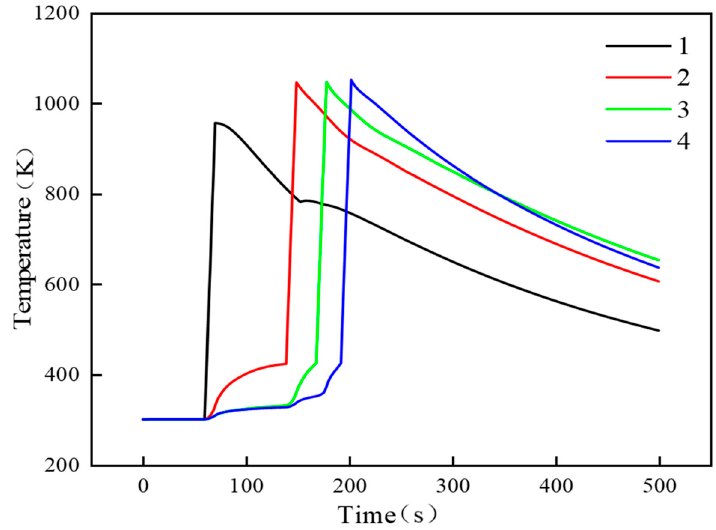
Figure 11. The maximum body temperature of each battery in scheme A under the condition of TR (when setting No. 1 battery TR).